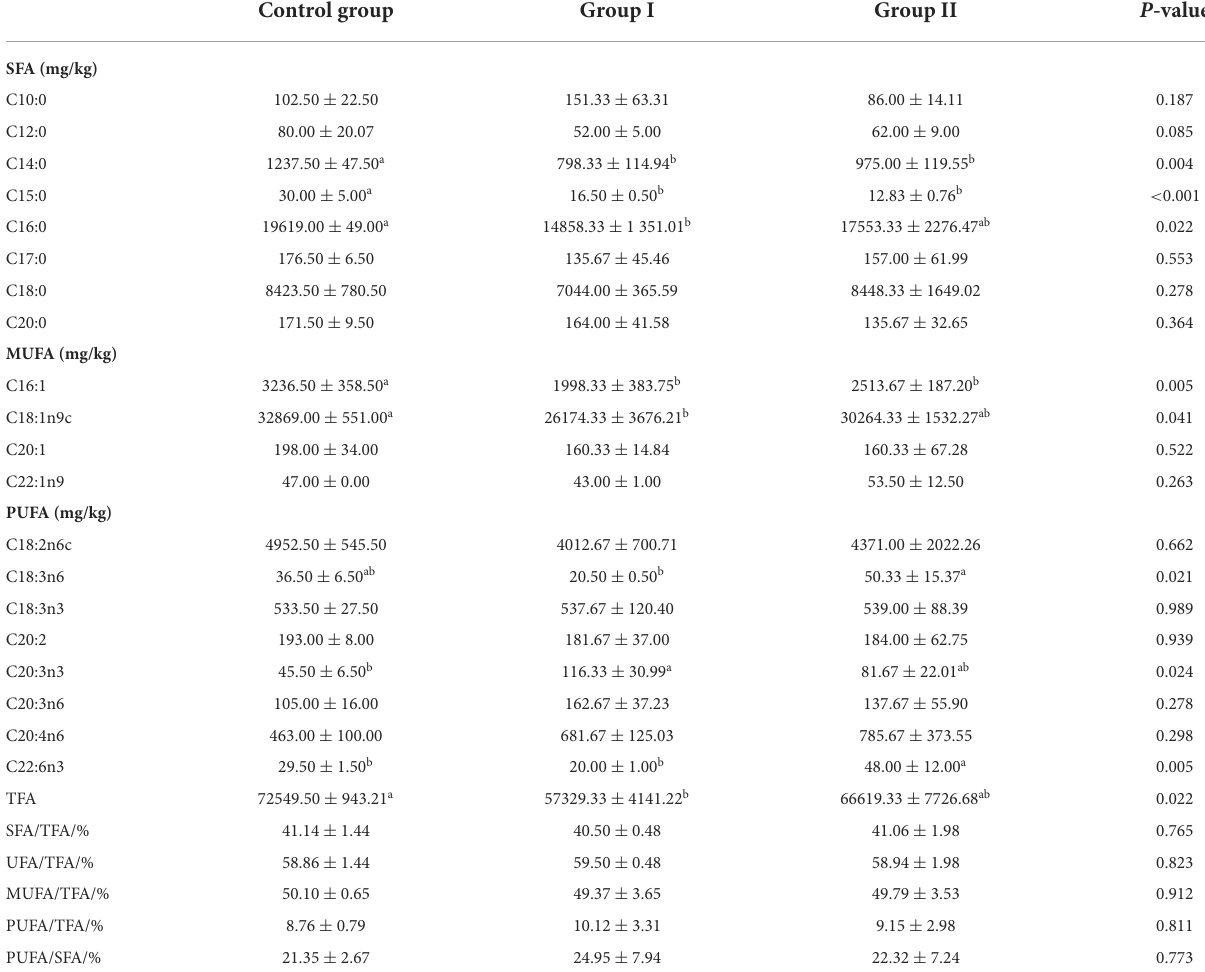
TABLE 9 Effects of dietary protein level on fatty acids in the muscle of finishing pigs (fresh meat). Control group Group I Group II P